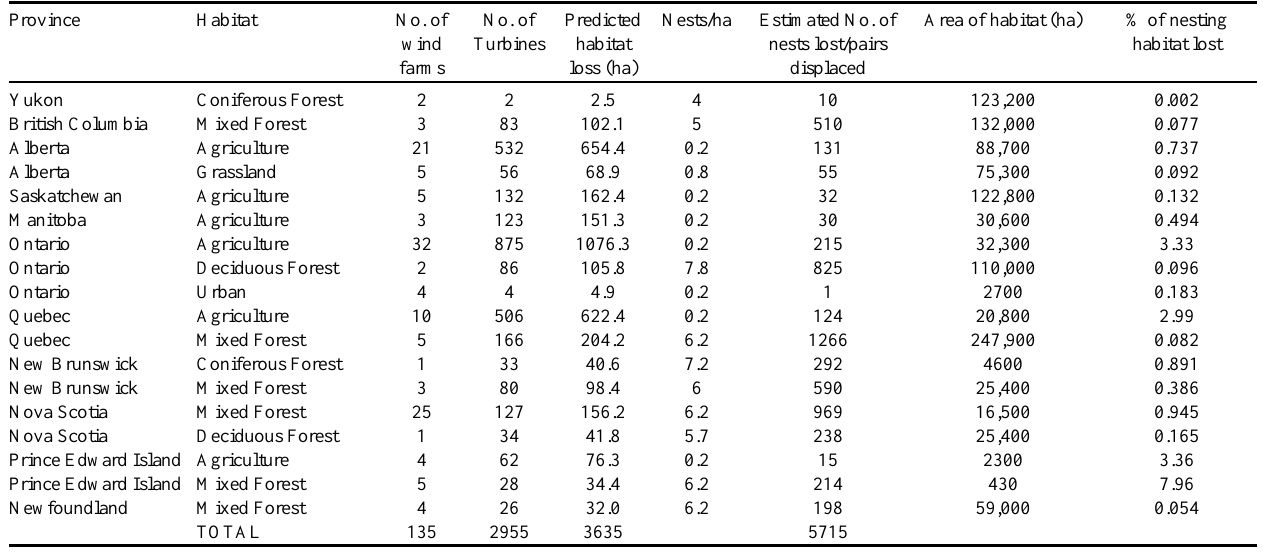
Table 3 . Estimated habitat loss, number of nests lost, or breeding pairs displaced, and percent of nesting habitat lost for each habitat by